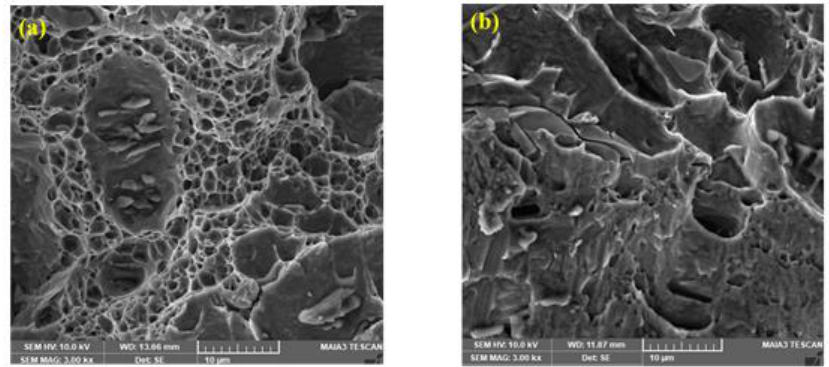
Fig. 9. SEM microstructures of fractured samples after tensile testing of rolled & 50 °C annealed.